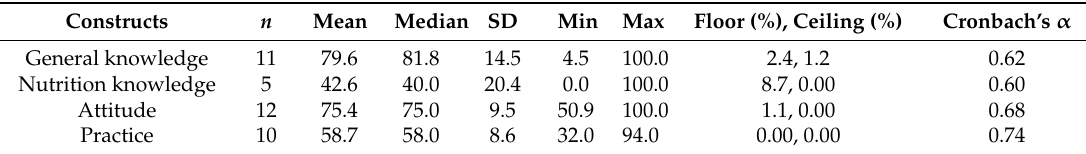
Table 4. Mean, standard deviation, percentage of floor and ceiling effects, and Cronbach’s α for vitamin D-related knowledge, attitude and practices of study participants ( n = 572).